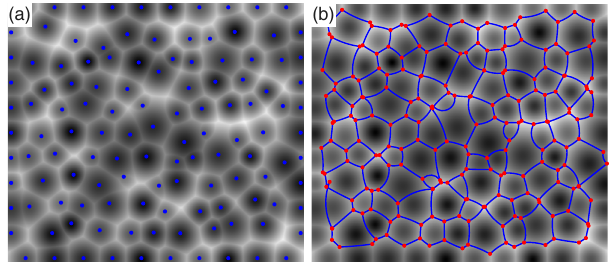
FIG. 8. (a) An example plot of the image of weighted distance from each generating point produced using MATLAB ’ s bwdist function and the algorithm described. The locations of the generating points q α are shown as blue dots. (b) The resultant CAP network. The segmentation output from MATLAB ’ s water- shed algorithm is used to infer the triangulation topology. This is then passed into our forward equations to generate the exact positions of vertices and curvatures of edges. The result, using the original values for the generating points and the measured triangulation topology, is overlayed in blue over the original distance map.